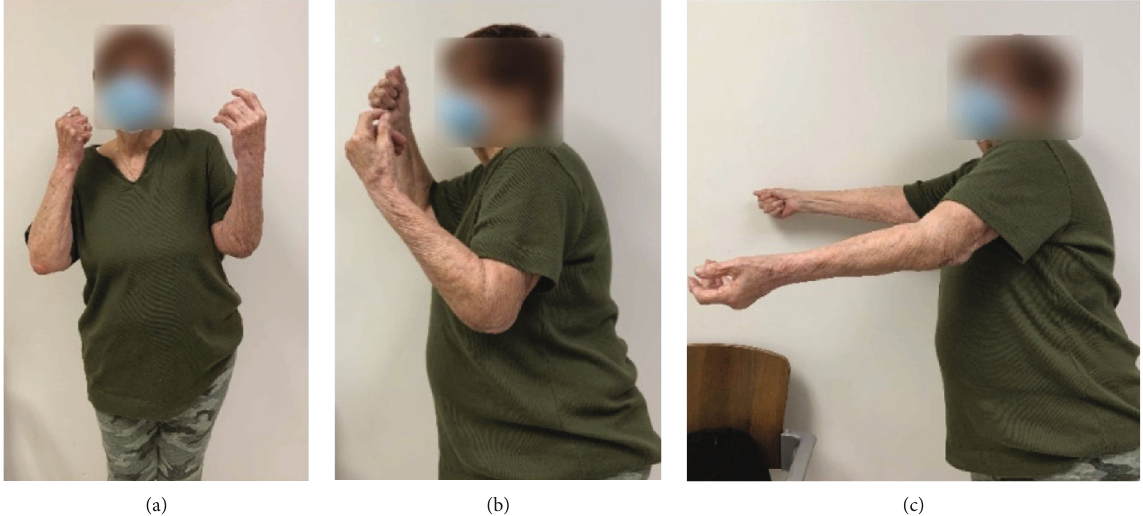
Figure 5: (a – c) 9-month postoperative clinic photos showing functional motion (10-130 degrees). (a, b) Symmetric elbow fl exion with 130 degrees of the surgical elbow and 140 of the contralateral elbow. (c) Symmetric elbow extension with the surgical (left) elbow demonstrating 10 degrees short of full extension compared to the full extension of the contralateral elbow.